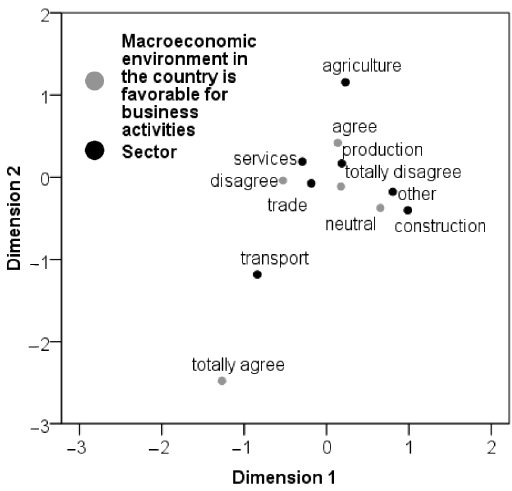
Figure 6. Correspondence analysis/the Czech